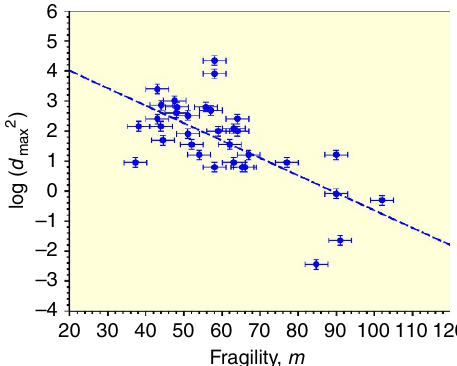
Figure 1 | Plot of log( d max 2 ) versus the dimensionless parameter t rg . Dashed line is the result of a linear regression least squares fit with an average slope of L t ¼ 28.5. The coefficient of determination for the linear fit is R 2 is 0.598. Error bars are estimated expeimental errors as described in the text.